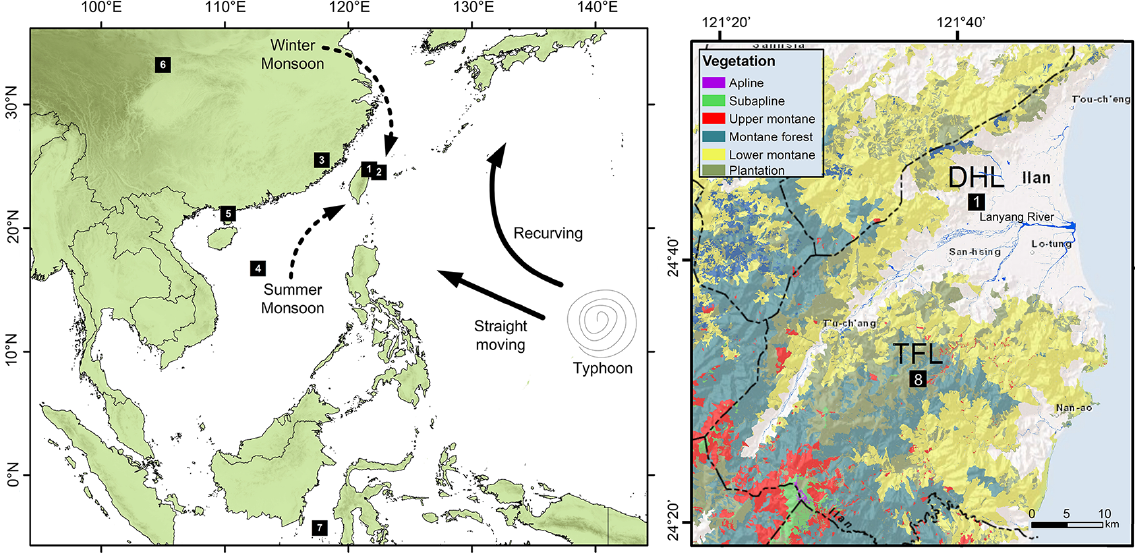
Figure 1. Maps showing the location of Dahu Lake (DHL) with modern vegetation cover (right). Locations (black squares) are used for discussions, as follows: (1) DHL; (2) South Okinawa Trough; (3) Fujian Province; (4) Cattle Pond, Dongdao Island; (5) Lake Huguang Maa; (6) Wanxiang Cave; (7) Makassar Strait; (8) Tsuifong Lake (TFL).